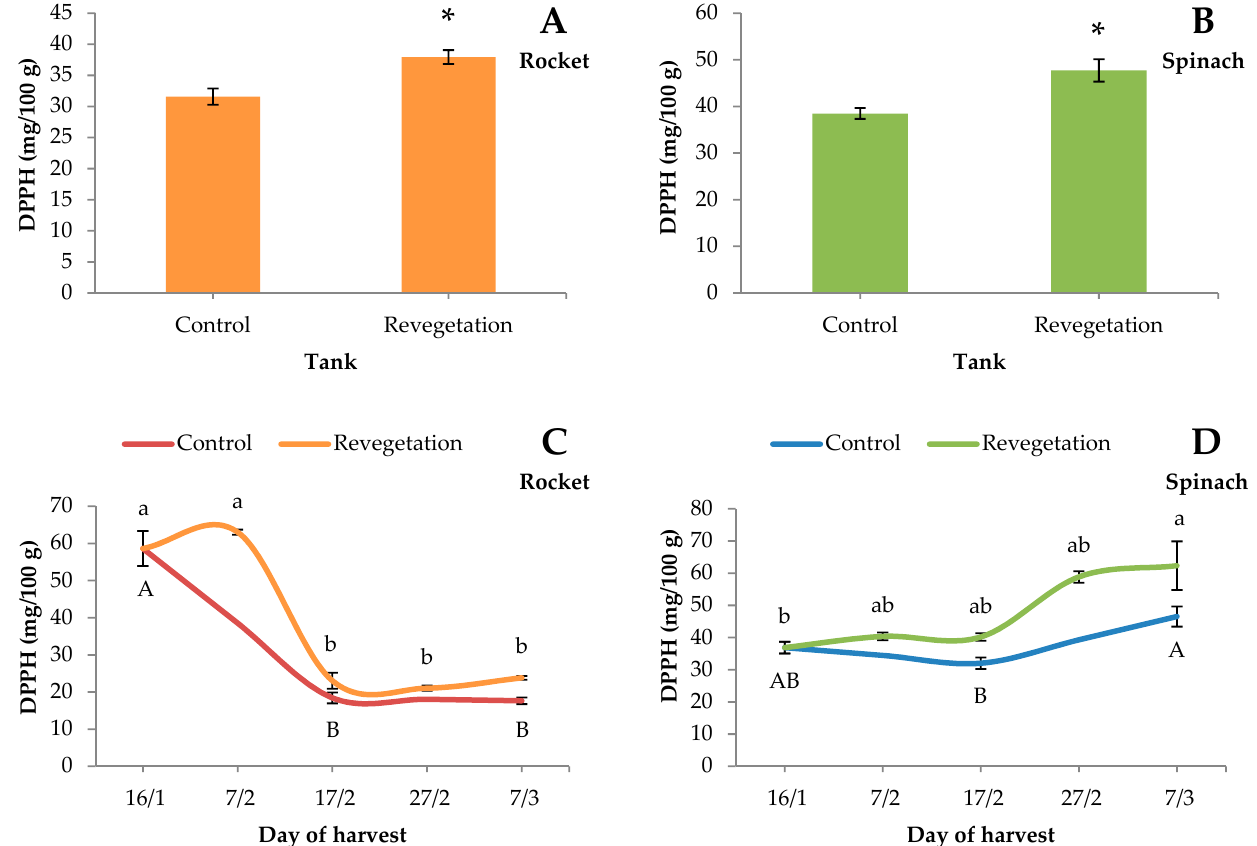
Figure 4. DPPH scavenging activity derived from all harvests ( A , B ) or from individual harvests ( C , D ) of rocket ( A , C ) and spinach ( B , D ) baby leaves cultivated in control or revegetation tanks. Means of control and revegetation tanks were computed from three and five harvests, respectively. In ( A , B ), bars ( ± SE) followed by an asterisk are significantly greater ( p ≤ 0.05). In ( C , D ), lines ( ± SE) followed by different letters (upper-case or lower-case) are significantly different ( p ≤ 0.05).